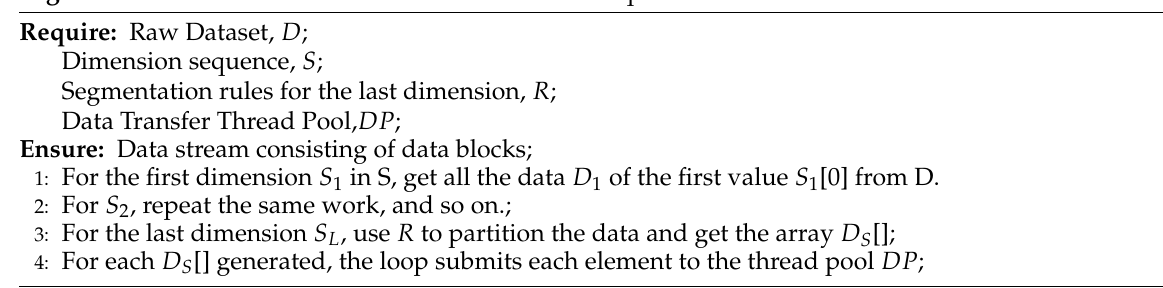
Algorithm 1 Partition and transmission of MVFD in